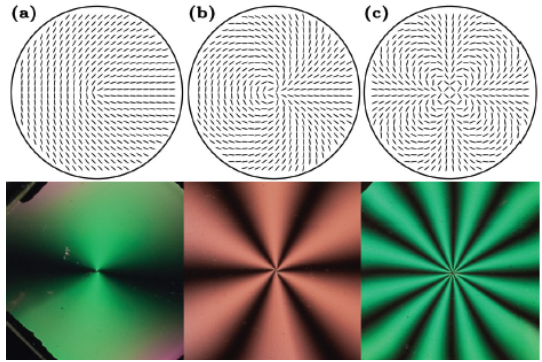
Figure 8. High resolution LC patterns for switchable q-plates made by photoalignment